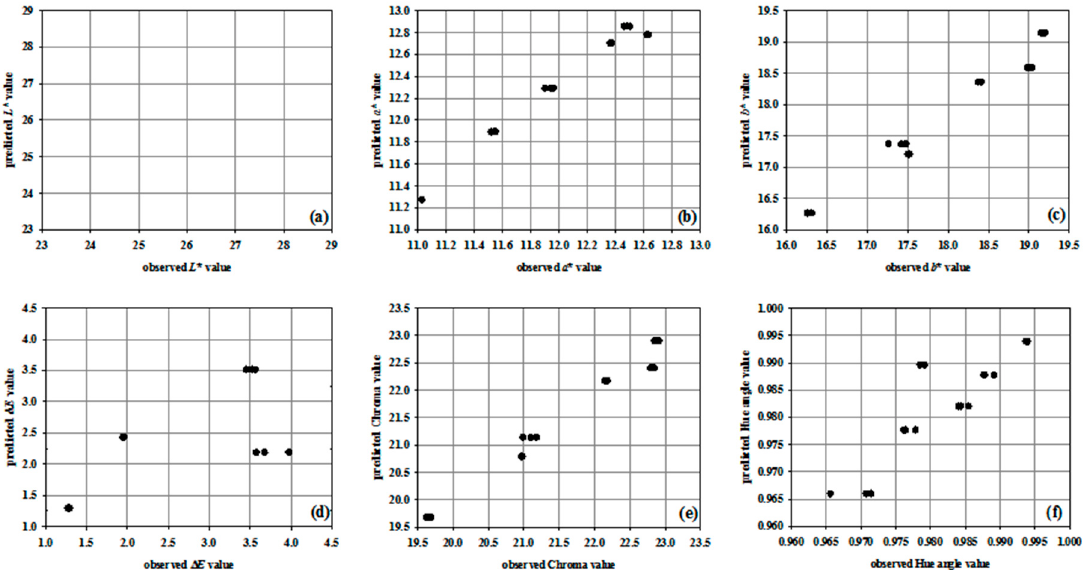
Figure 3. Non-linear regression models for description of colour component change during storage of V1KMK estimated using Eureqa Formulize: ( a ) L * (not determined), ( b ) a* , ( c ) b* , ( d ) ∆ E , ( e ) Chroma, ( f ) Hue angle ( R 2 = n / m , 0.977, 0.965, 0.738, 0.973, 0.642). Table 4. Non-linear regression models coefficients for description of color component change during